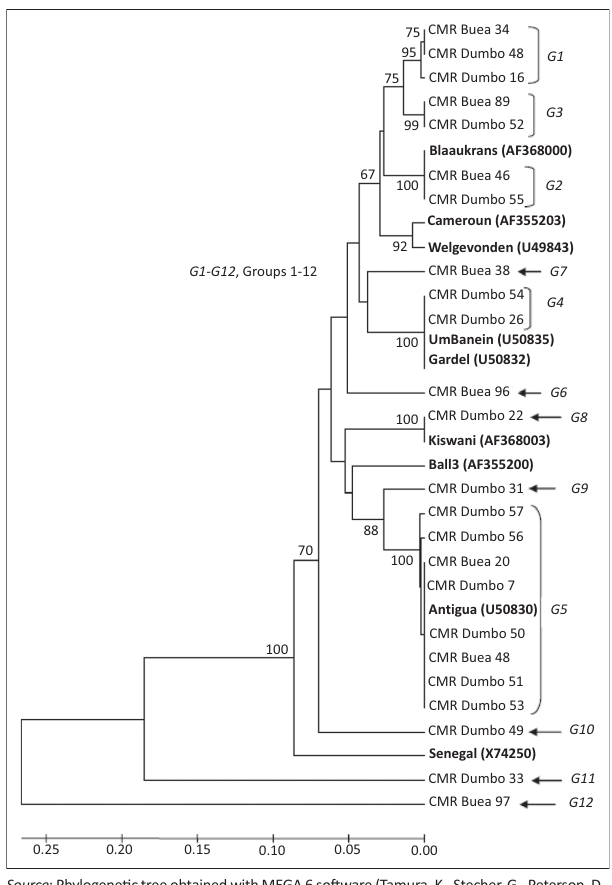
Molecular Biology and Evolution 30, 2725–2729. http://dx.doi.org/10.1093/molbev/mst197 FIGURE 2: Phylogenetic tree based on the partial amino acid sequences of MAP1 of 24 Ehrlichia ruminantium strains reported in this study, and seven reference strains (bold and accession numbers put in